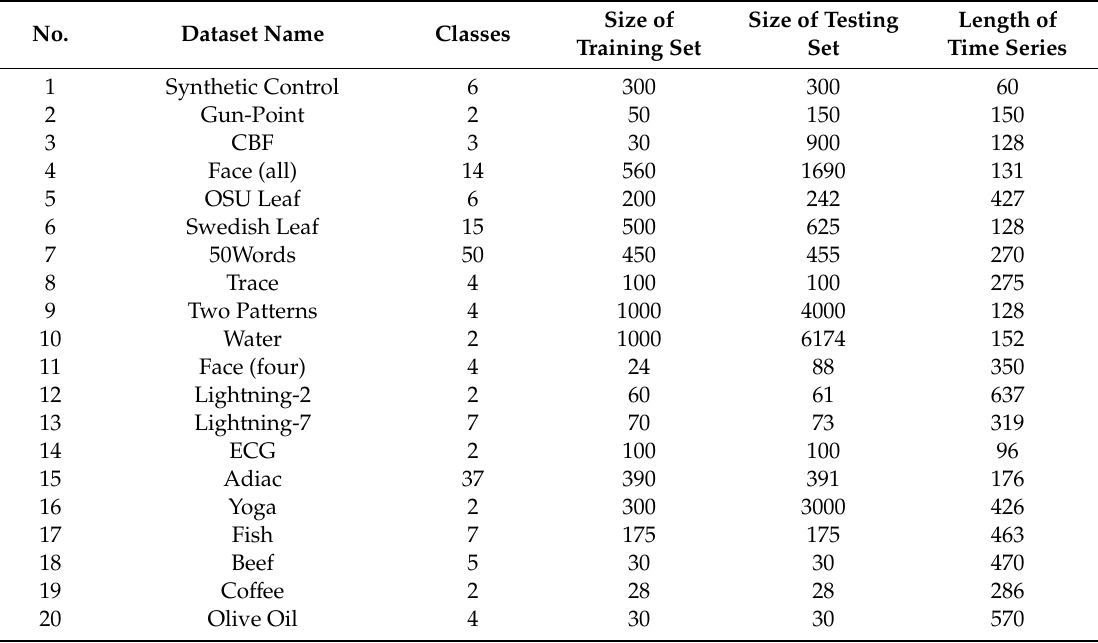
Table 1. Information on the